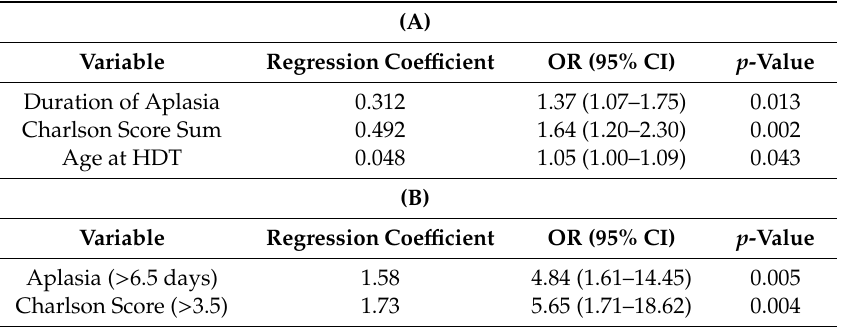
Table 3. Multivariant binary regression analysis of independent risk factors for ICU admission in relation to their HDT and ASCT treatment. A: continuous variable. B: binary